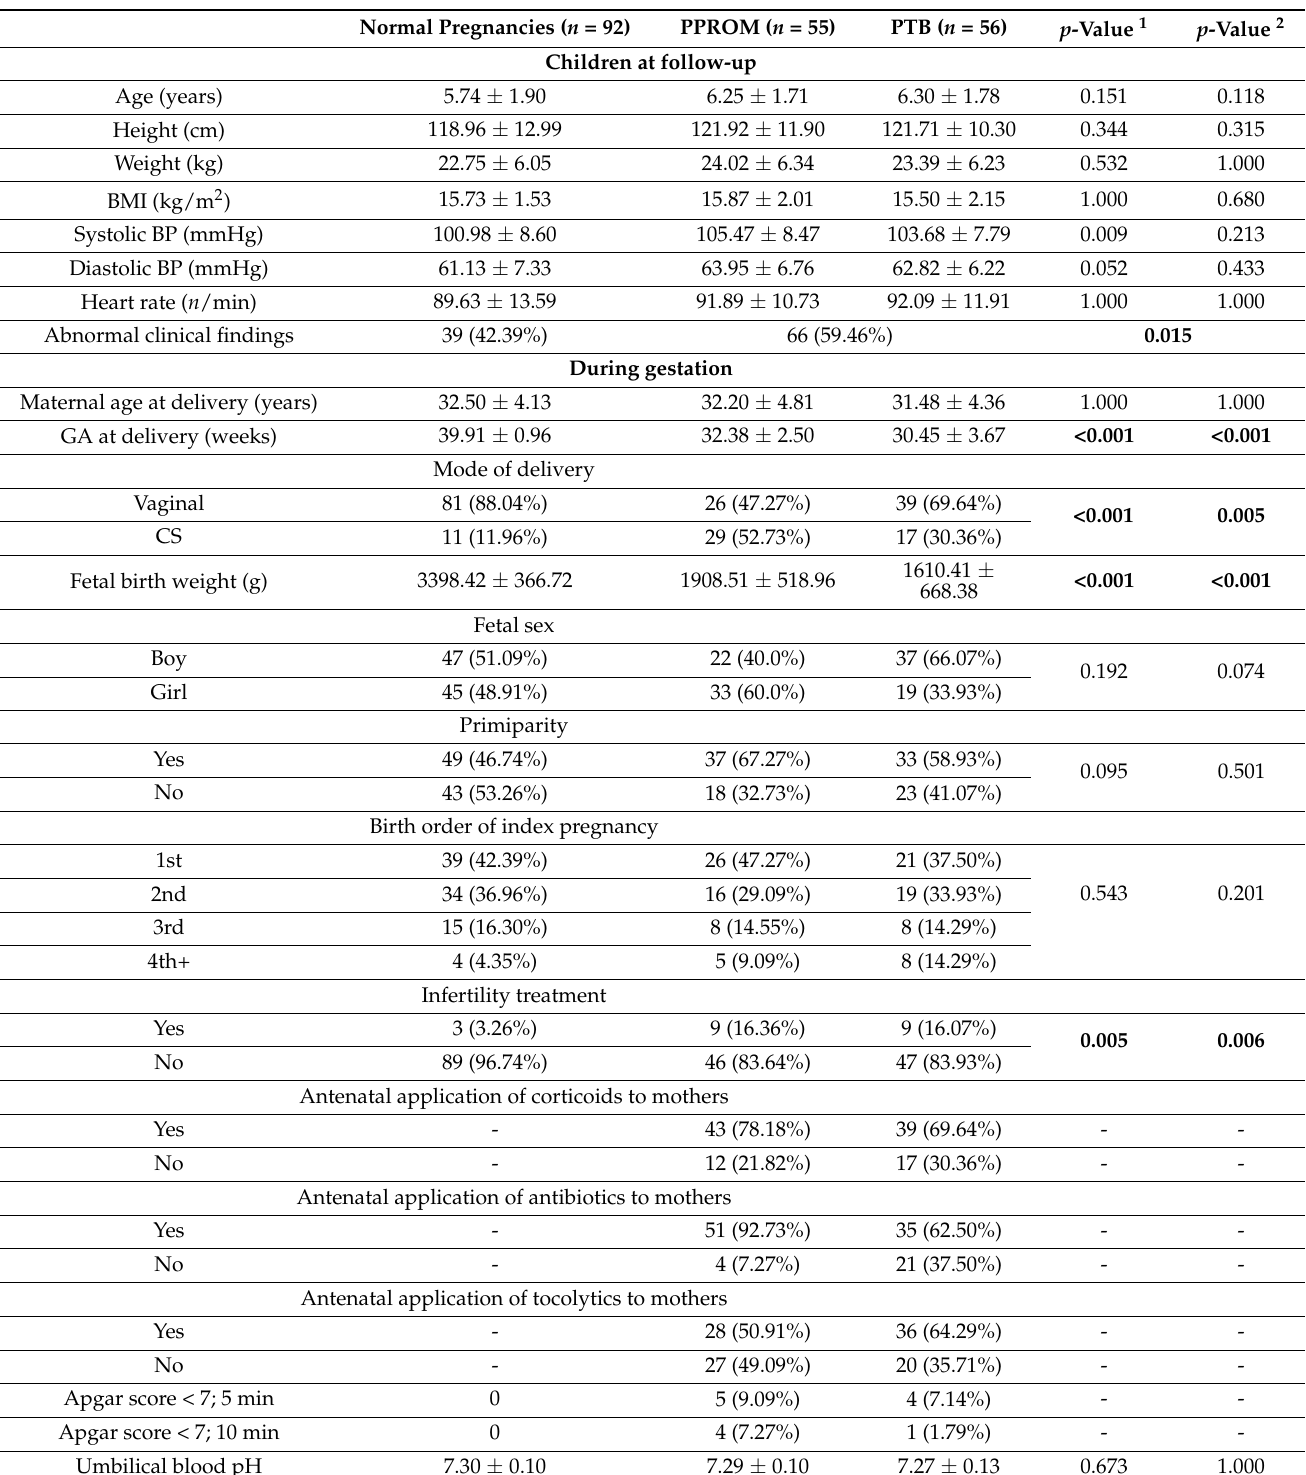
Table 1. Characteristics of cases and